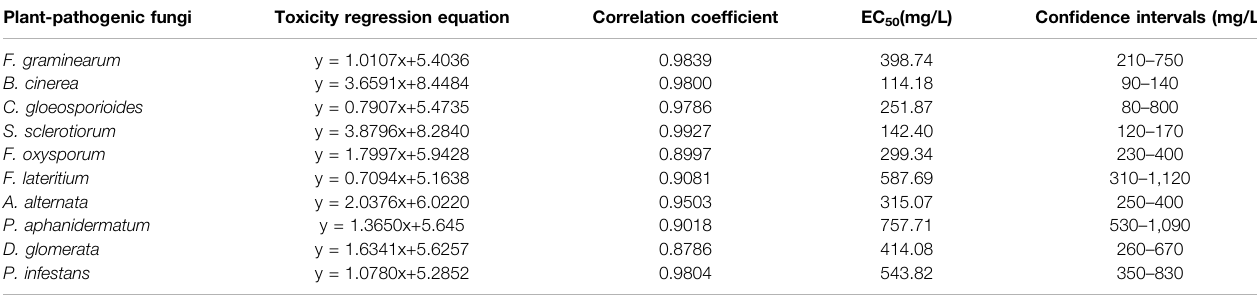
TABLE 1 | Toxicity test results of extracts of Radix Aucklandiae against several plant-pathogenic